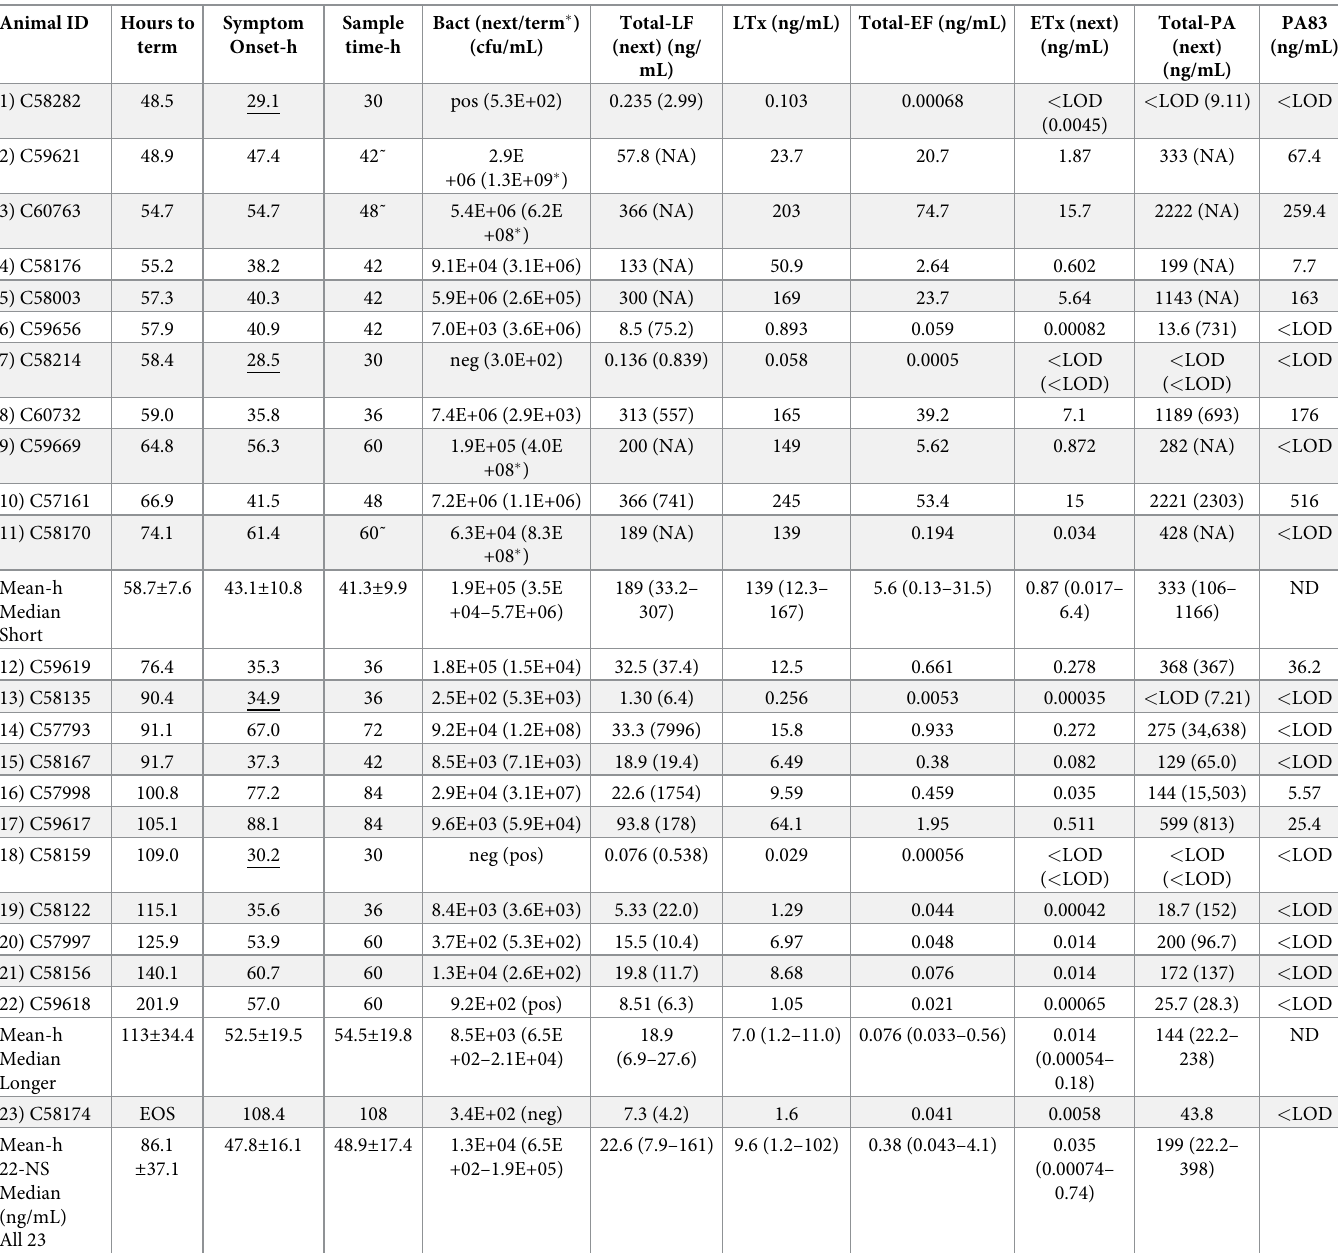
Table 4. Symptom onset biomarker